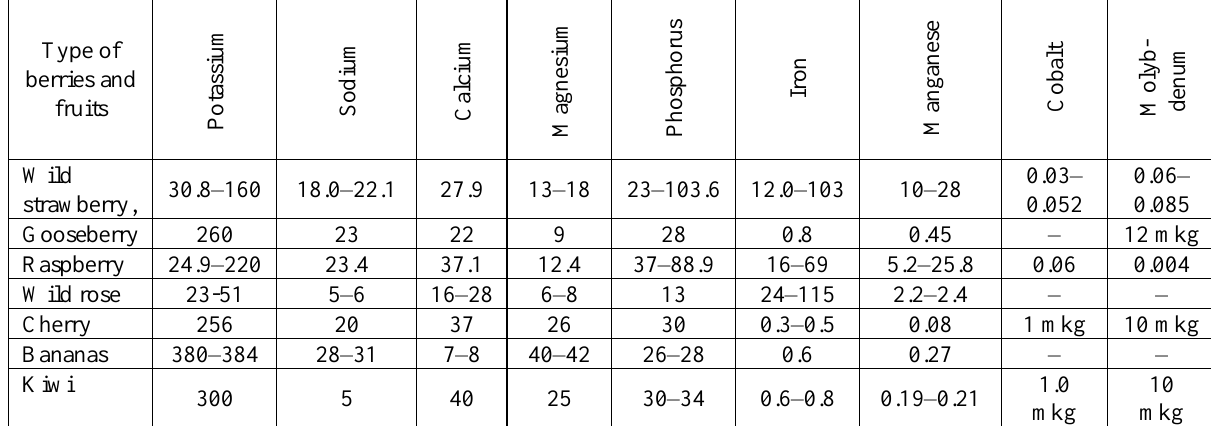
Type of berries